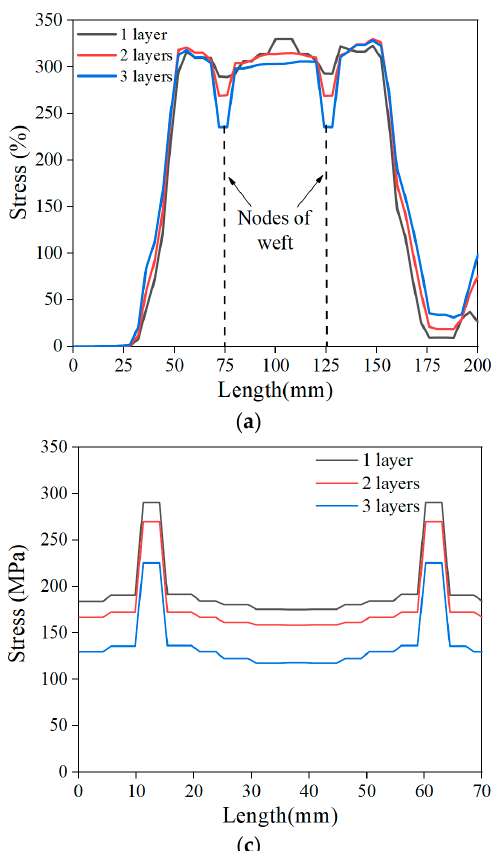
Figure 17. Stress–strain of BFRP grid: ( a ) stress in the length direction of the specimen, ( b ) strain in the length direction of the specimen, and ( c ) stress in the width direction of the specimen.